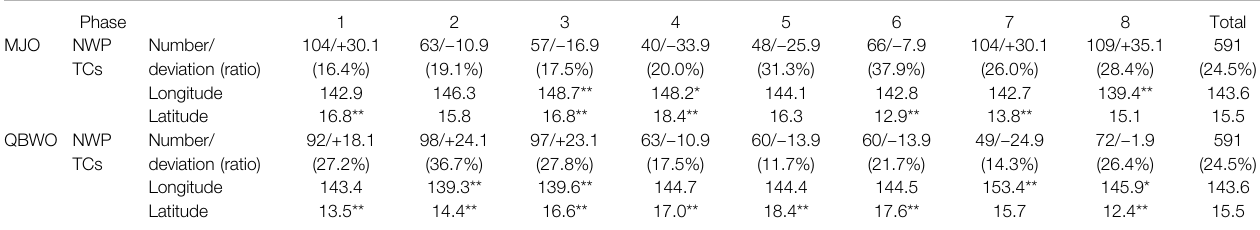
TABLE 2 | The number and mean genesis location of NWP TCs (excluding local TCs that formed over the SCS) in each phase of MJO and QBWO.